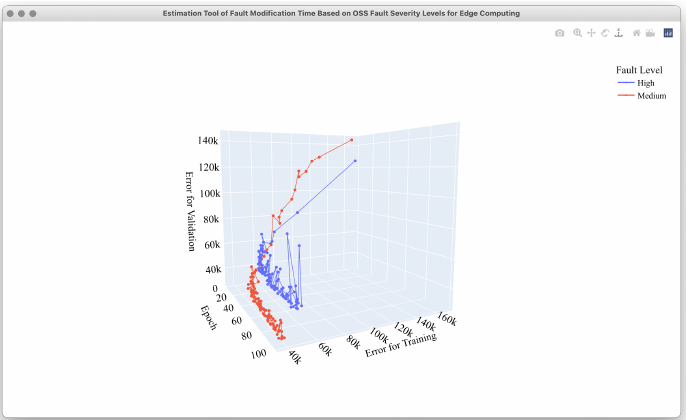
Figure 9. The overall picture of the estimated error between validation and training in case of 30% testing data.